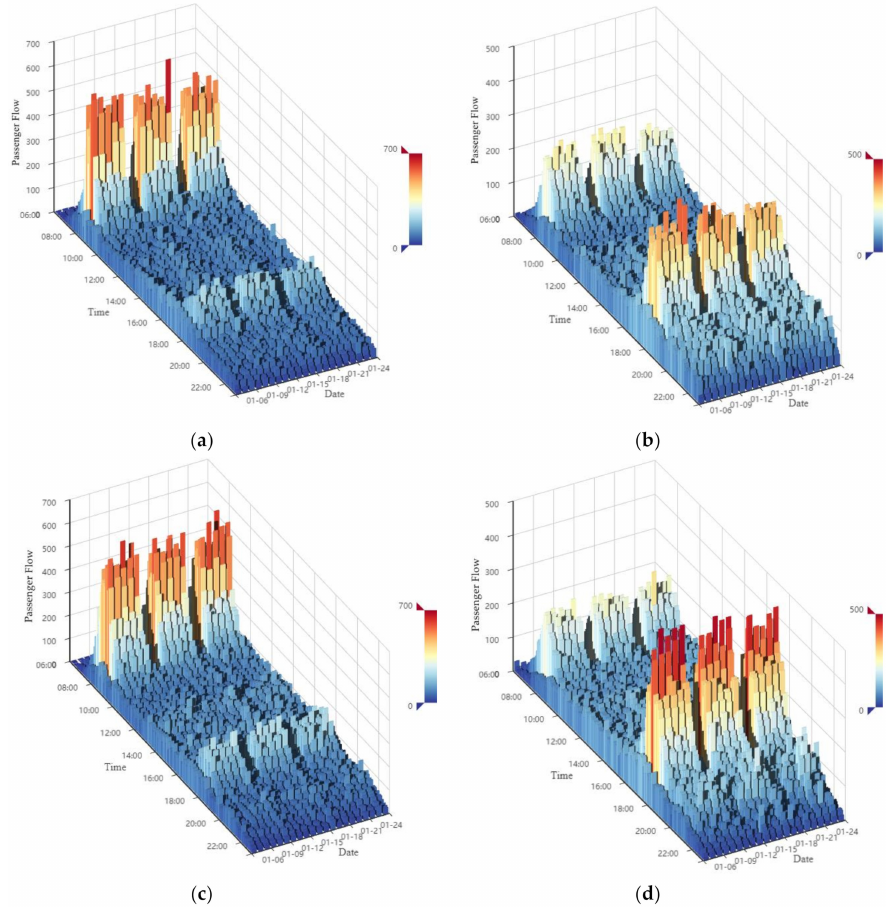
Figure 4. Passenger flow of the study metro transfer stations: ( a ) exit passenger flow of the Q.R. Sta., ( b ) entrance passenger flow of the Q.R. Sta., ( c ) exit passenger flow of the J. Sta, and ( d ) entrance passenger flow of the J.